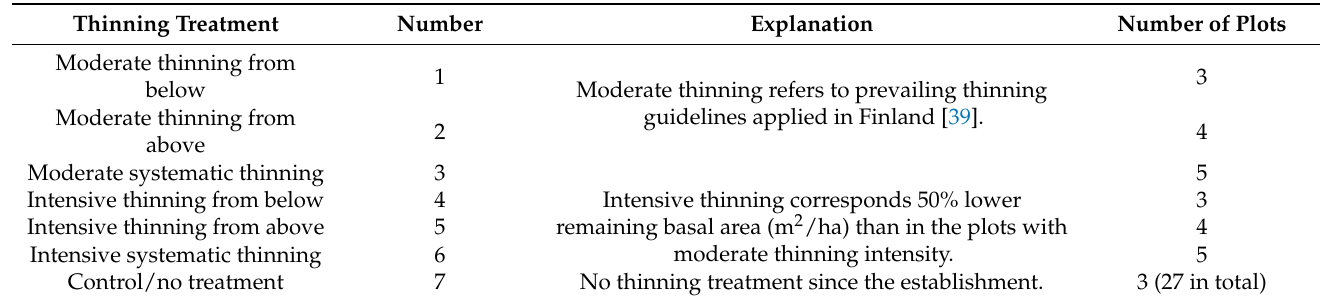
Table 2. Different thinning